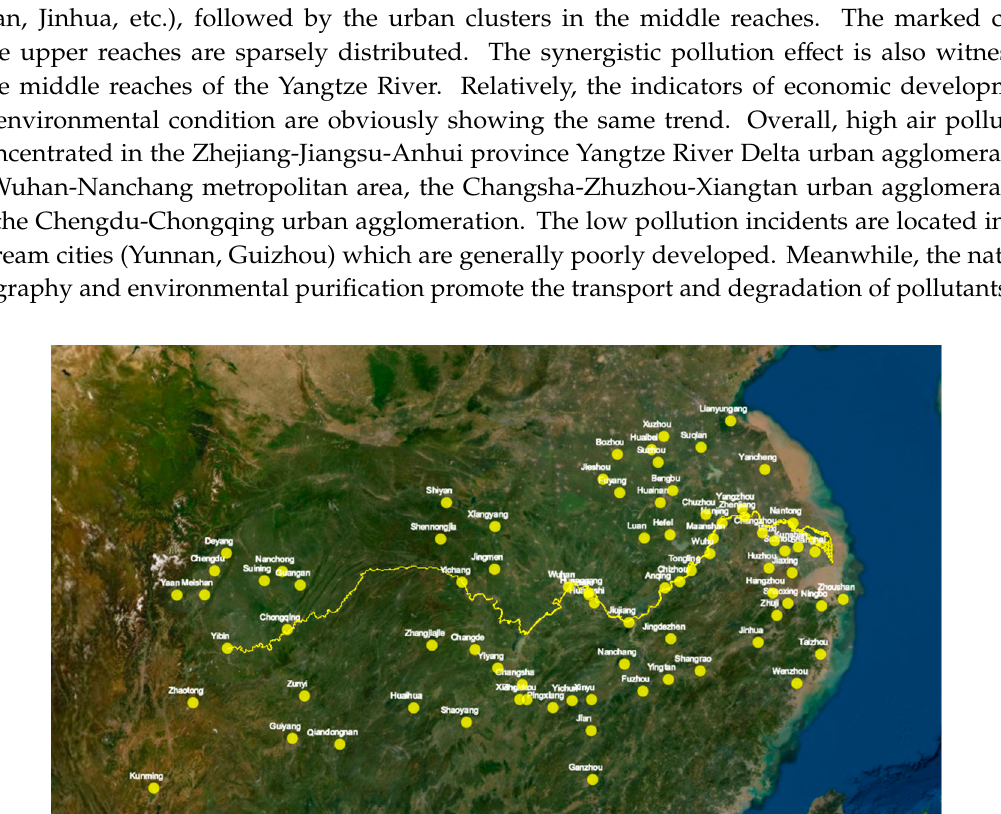
Table 1. Categories of high-frequency keywords (found more than 8 times).